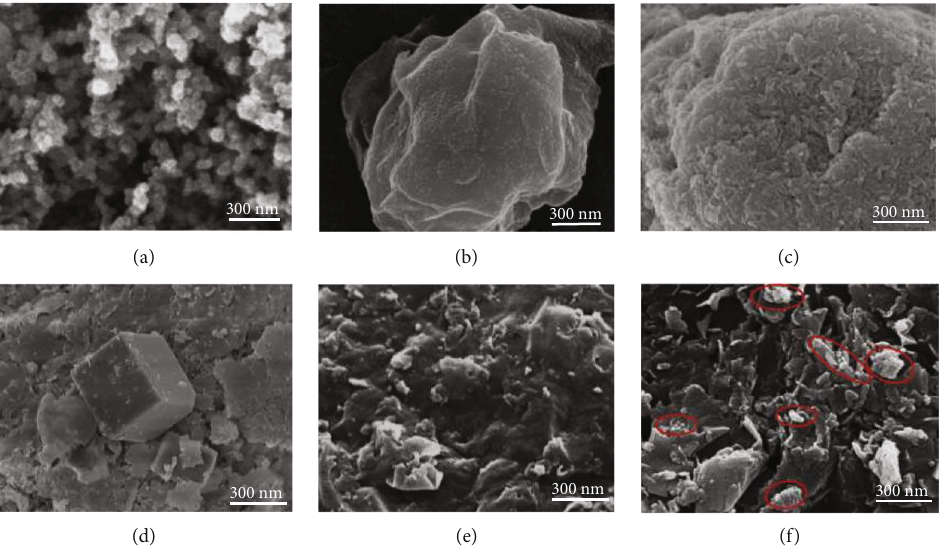
Figure 4: SEM images of (a) Bt-nZVI [51] synthesized by liquid-phase reduction and (b) heteroaggregates of Mt with nZVIs [15]. TEM images of (c) Bt and (d) Bt-supported “ green ” nZVI synthesized by green synthesis [60]. SEM images of (e) Fe-Mt and (f) Fe-Mt-H synthesized by thermal reduction method